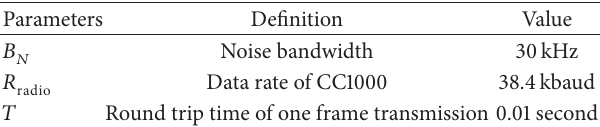
Figure 6: Performance with multimedia traffic. Table 2: Parameter settings in experiment